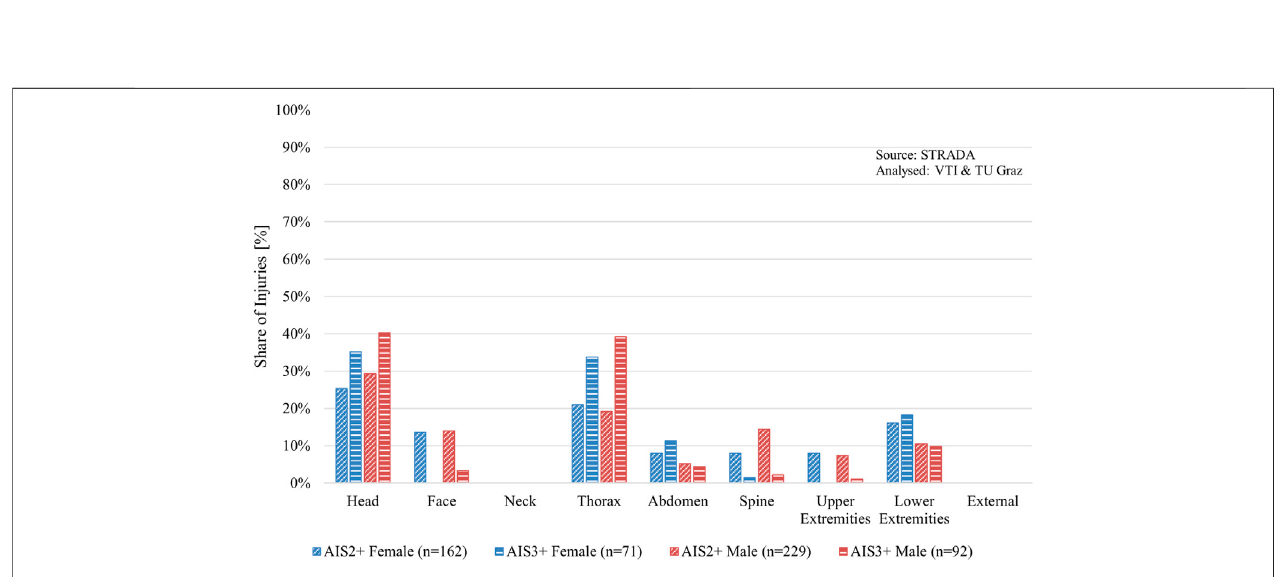
FIGURE 7 | Injured Body Regions as a function of gender and injury severity in Sweden.